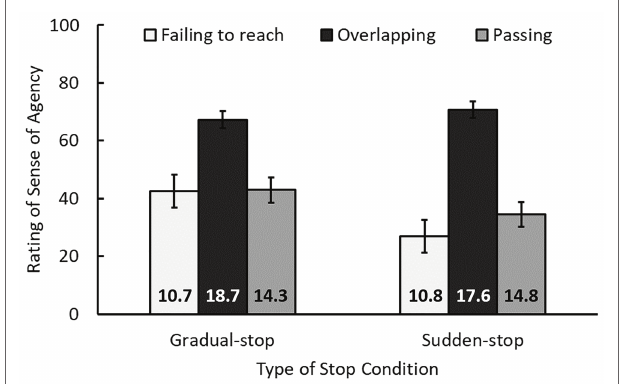
FIGURE 3 | SoA ratings and the number of trials (at the base of each bar) as a function of type of stop and circle stop position. Error bars indicate 95% confidence intervals. Failing to reach: circle stopped to the left of the goal. Overlapping: circle and goal overlapped by at least one pixel. Passing: circle stopped to the right of the goal. The total number of trials for the three stop position conditions is not 45, because approximately one trial of each participant’s data on average was omitted from